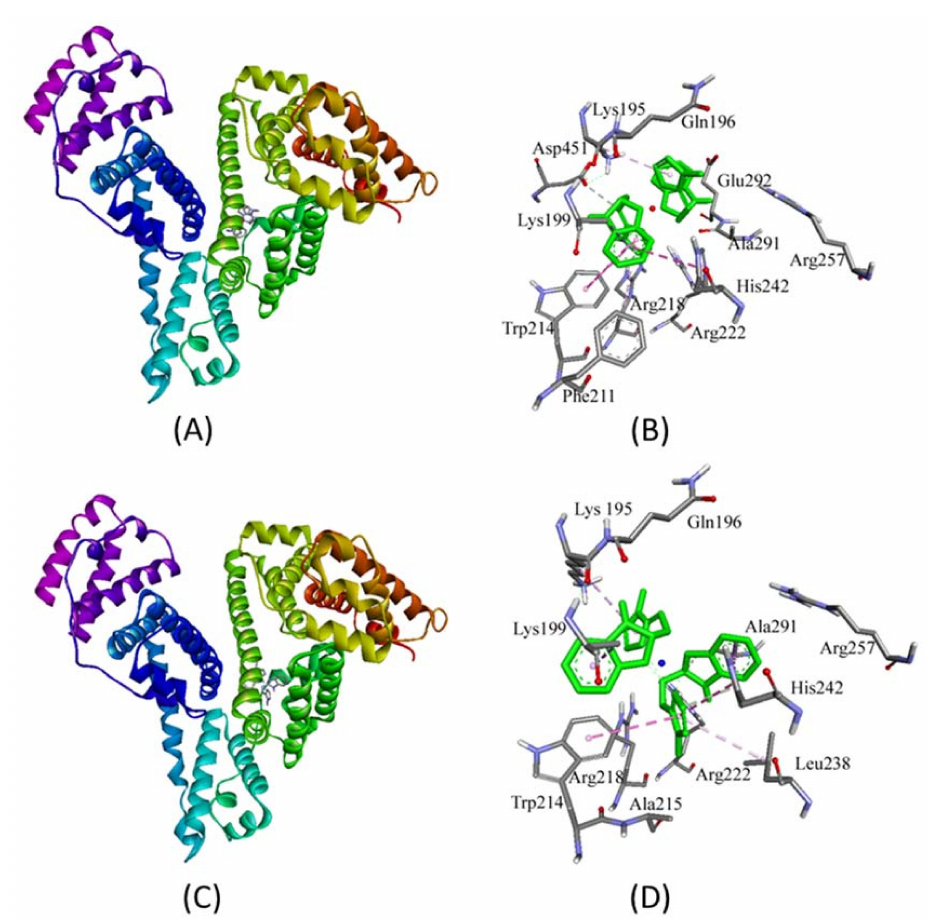
Figure 3. Molecular docking of complexes 1 and 2 with HSA. Panels ( A , C ) show the binding of complexes 1 and 2 near Sudlow’s site I in subdomain IIA respectively, and panels ( B , D ) represent the involvement of different amino acid residues of HSA in stabilizing complex with 1 and 2 , respectively. The amino acid residues are color coded according to element